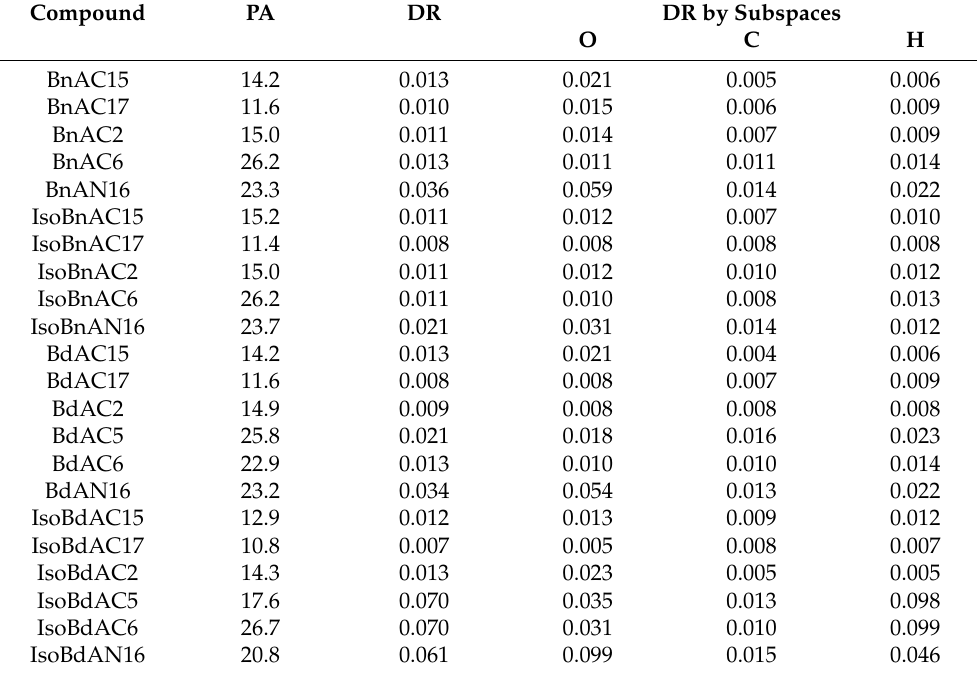
Table 2. RD between study compounds and their respective anions and PA values.